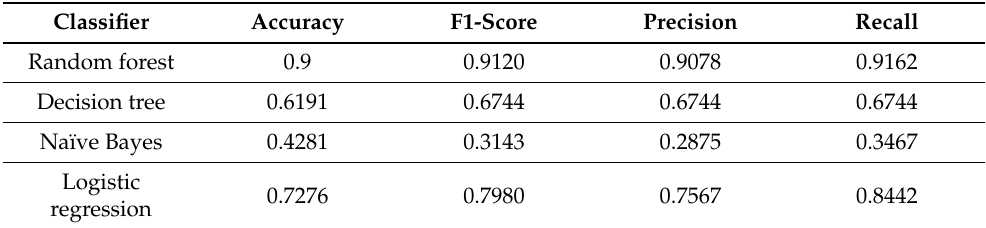
Table 7. Performance of multiple machine learning classifiers on the GTZAN